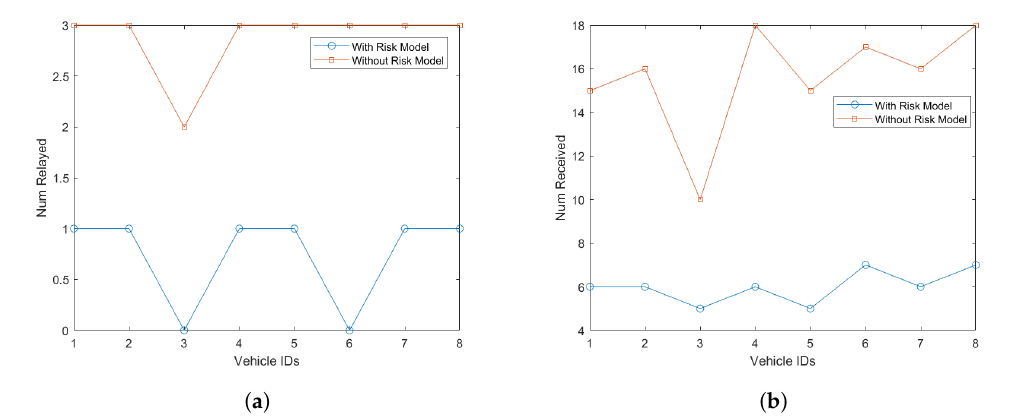
Figure 6. Simulation-based communication overhead analysis. ( a ) Number of packets relayed; ( b ) Number of packets